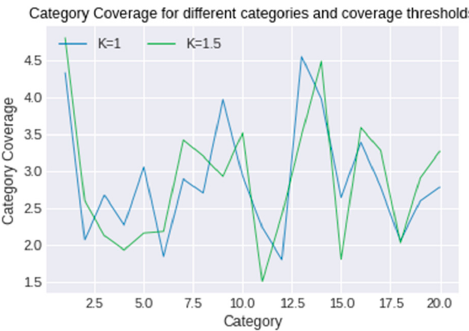
Figure 1. Coverage per provider for K = 1 and K = 1.5.